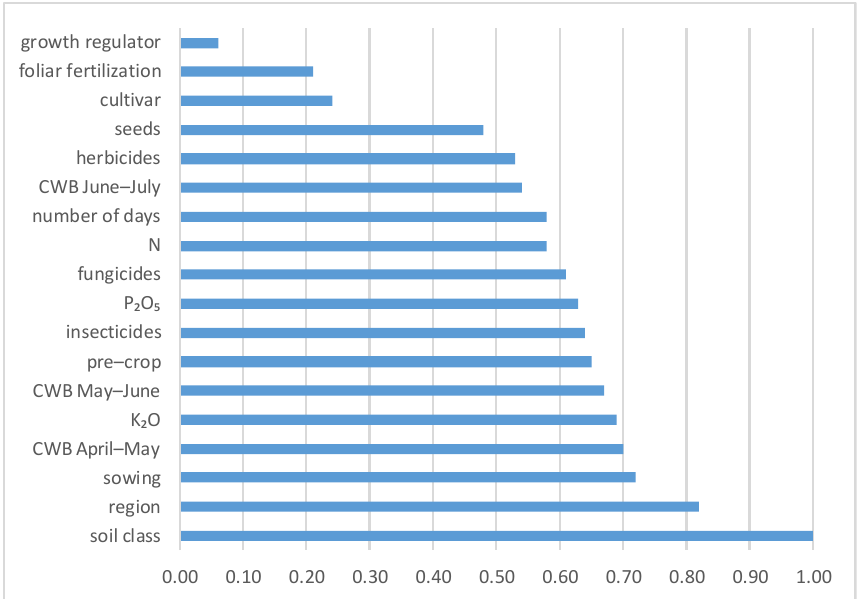
Figure 5. Importance of independent variables in the scale 0–1 (importance 0—variable is never featured in the tree, importance 1—the highest importance in the explanation of yield variability) for spring triticale.